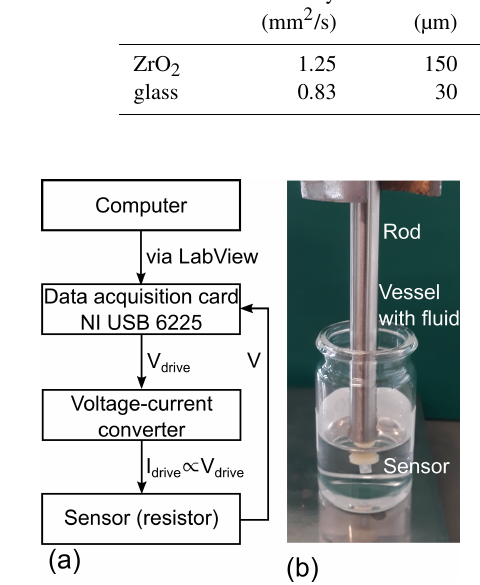
Figure 4. Temperature (cid:49)T DC as a function of drive frequency (blue dots). A decrease of 0 . 8 ◦ C is visible which is most pronounced if the drive frequency is smaller than 5Hz and the thermal wave can penetrate the zirconium oxide substrate, indicated by δ ZrO If the drive frequency is bigger than 100Hz, the penetration depth is smaller than the thickness of glass passivation δ glass and the in- crease in temperature is saturated. The phase φ 1 ω of the 1 ω signal as a function of drive frequency is shown by red squares. This phase is constantly 0 ◦ as